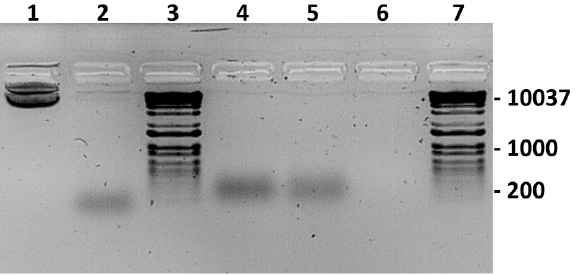
Figure 17. Agarose gel electrophoresis of GST-fused NS5 of BTV-8. Lane 1: pACT-5C plasmid (250 ng); lane 2: pACT-5C plasmid (250 ng) treated with Turbo DNAse (0.2 units, 1× reaction bu ff er, 1 h at 37 °C) showing degradation products; lanes 3 and 7: DNA size marker; lane 4: GST-fused NS5 of BTV-8 (denatured by boiling for 10 min); lane 5: GST-fused NS5 of BTV-8 (denatured by boiling for 10 min) treated with Turbo DNAse (0.2 units, 1× reaction bu ff er, 1 h at 37 °C); and lane 6: GST-fused NS5 of BTV-8 (denatured by boiling for 10 min) treated with RNAse A (0.4 µg in 1× reaction bu ff er, 1 h at 37 °C). The products were run in a 1.5% agarose gel in 0.5× TBE bu ff er.